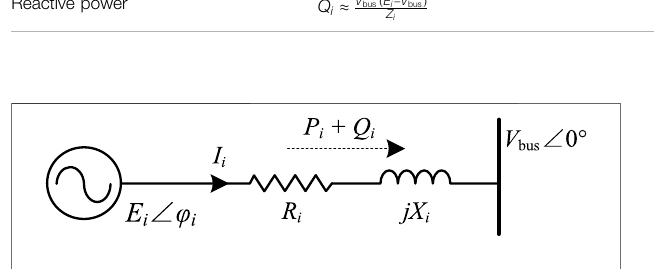
FIGURE 3 | Equivalent circuit of the DEU i